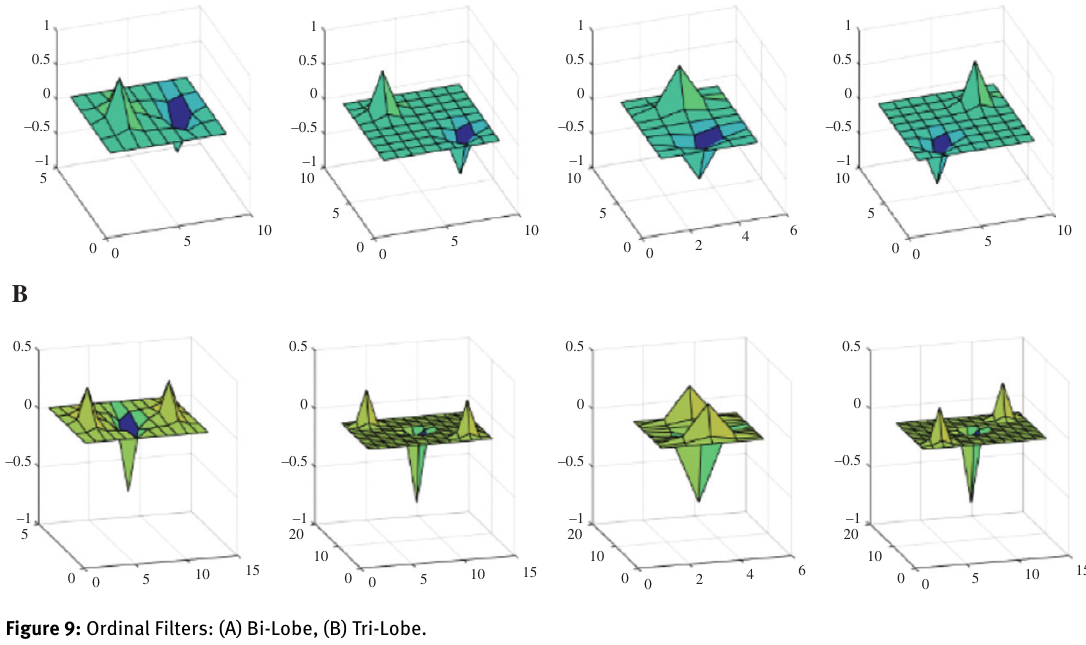
Figure 9: Ordinal Filters: (A) Bi-Lobe, (B) Tri-Lobe. For imaginary Gabor features image Im µ , ν :